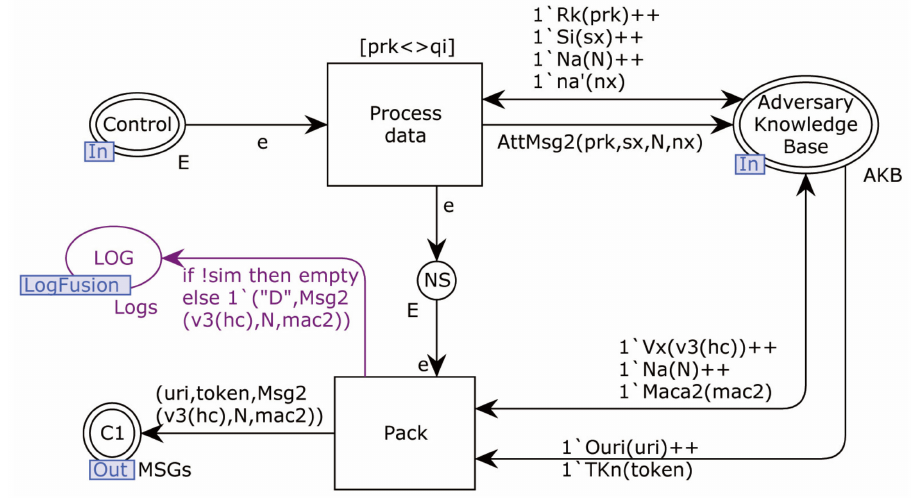
Figure 16. Adversary model sub-page